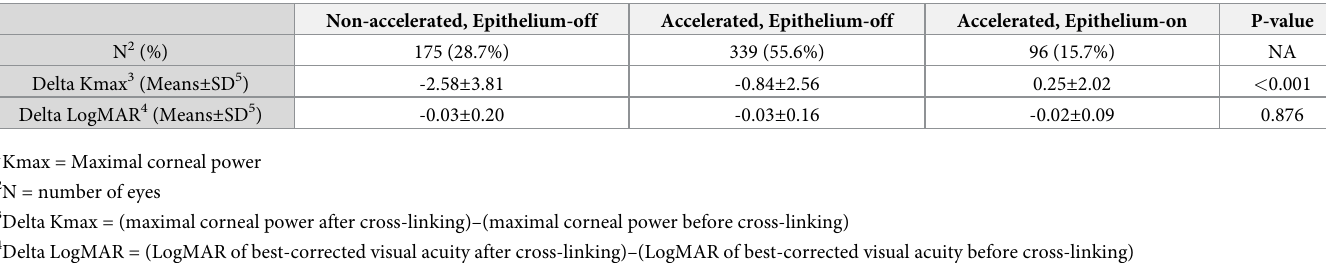
Table 2. Comparison of Delta Kmax and Delta LogMAR with different crosslinking protocols analyzed with ANOVA (p <